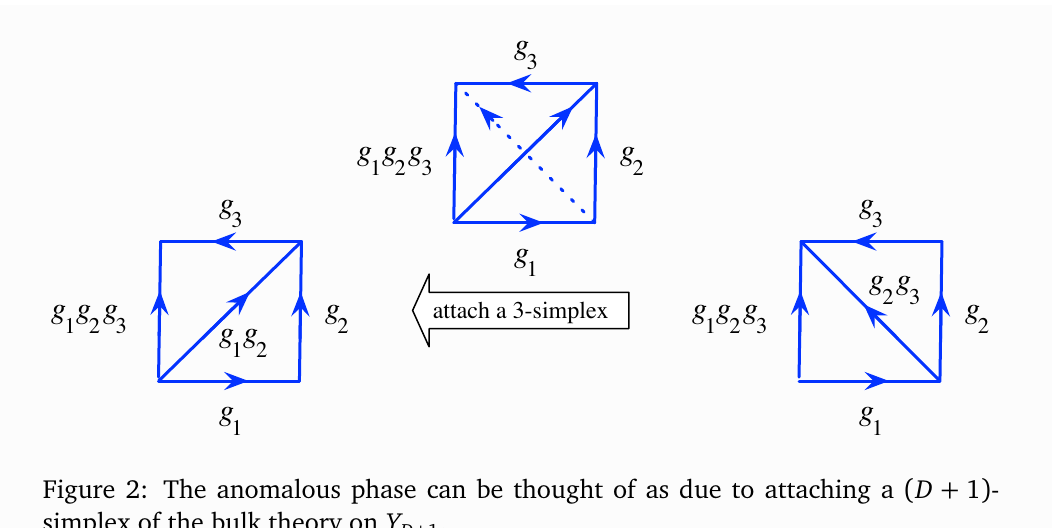
Figure 2: The anomalous phase can be thought of as due to attaching a ( D + 1 ) - simplex of the bulk theory on Y D + 1